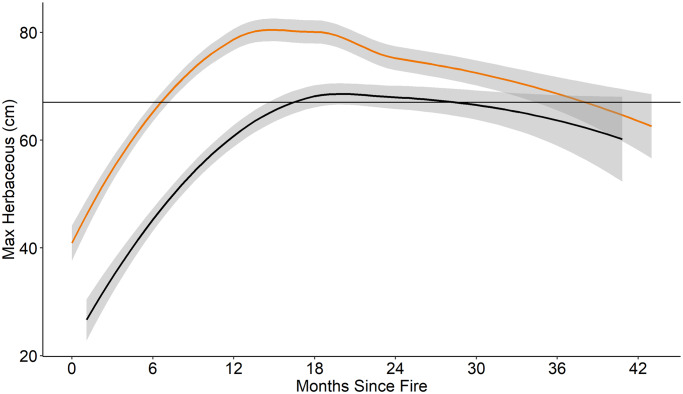
Maximum herbaceous vegetation.Maximum height (cm) of herbaceous vegetation in fire-only (orange) and pyric herbivory (black) treatments at all sites from 2014 to 2016. Shaded area indicates 95% confidence interval. Horizontal line represents maximum mean herbaceous vegetation height (67 cm) reported for prairie-chicken nest selection, as found in primary literature. *Regression lines and confidence intervals generated using “loess” locally-weighted smoothing function.